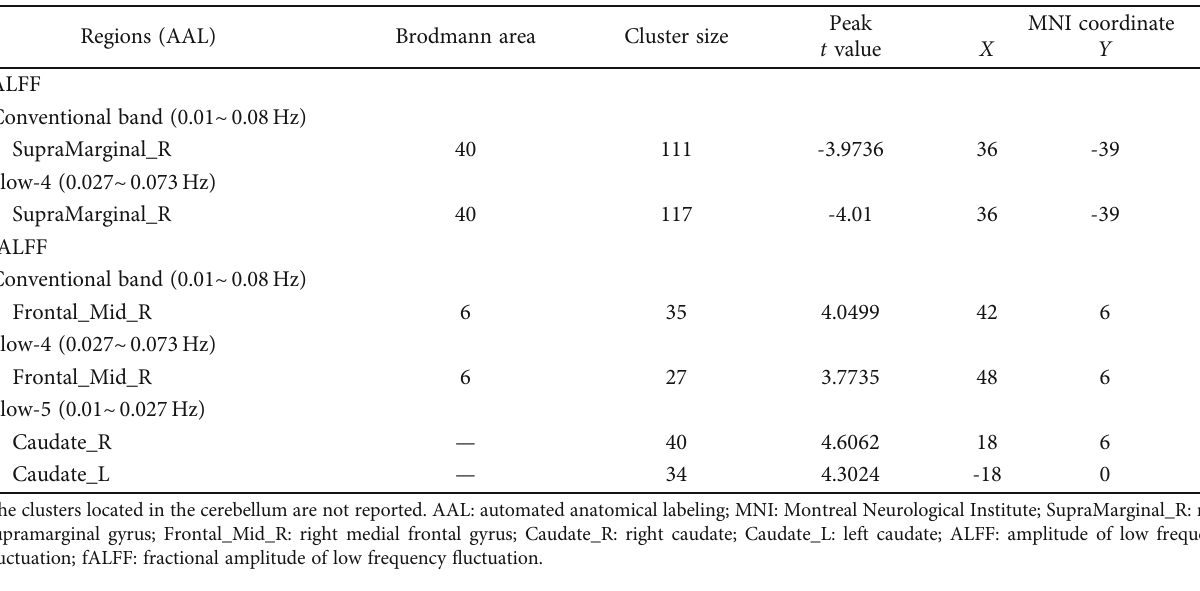
Table 2: Brain regions showing ALFF and fALFF di ff erences between groups.